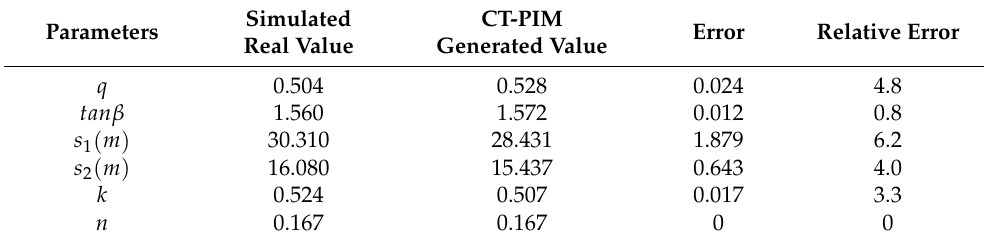
Table 2. Estimated CT-PIM parameters (under the 35 interferometric pairs).